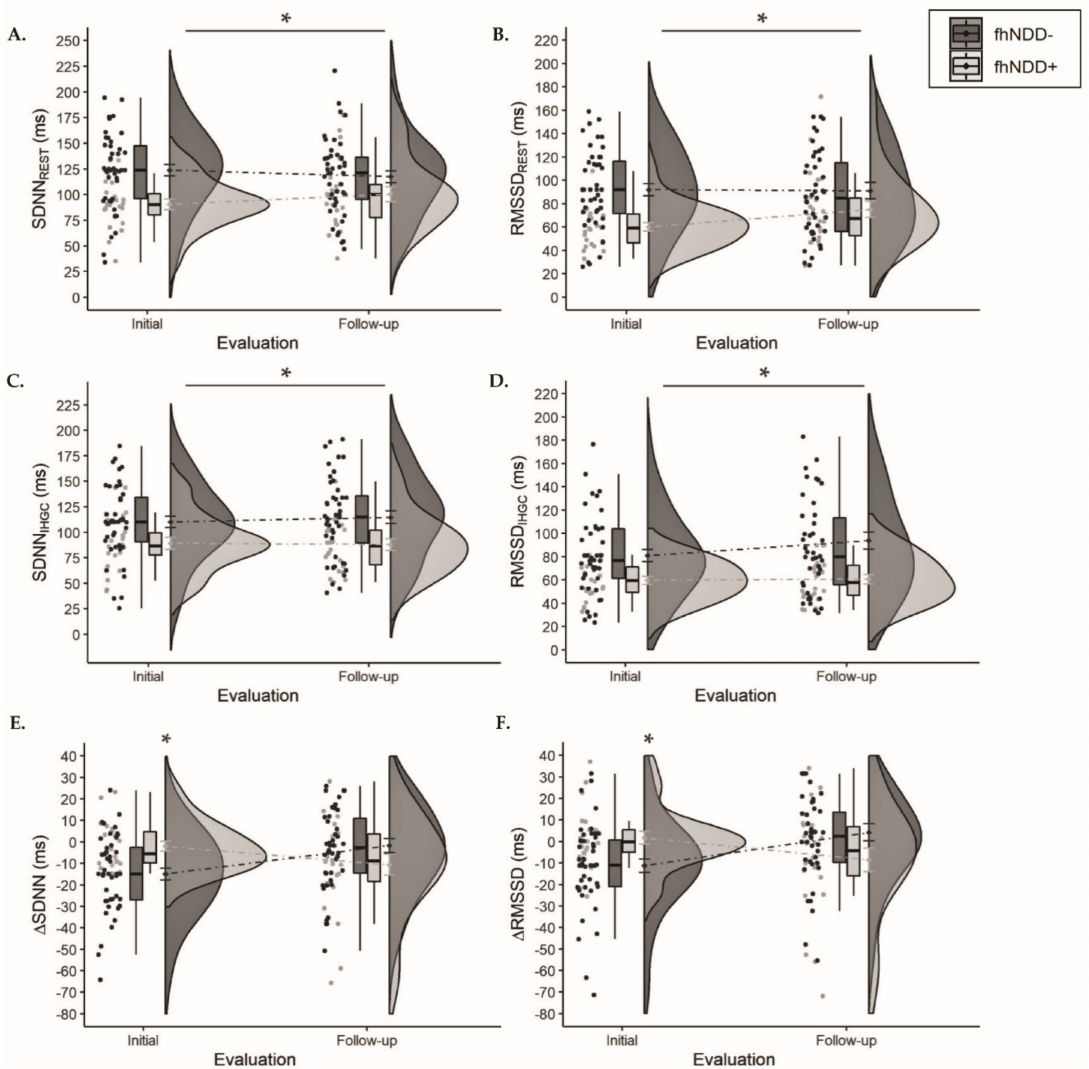
Figure 5. Group comparisons of HRV between those with a family history of neurodegenerative disease (fhNDD+; light gray) and without a family history of neurodegenerative disease (fhNDD − ; dark gray) during resonant breathing assessments at each evaluation. ( A ) SDNN at rest. ( B ) RMSSD at rest. ( C ) SDNN during isometric handgrip contraction (IHGC). ( D ) RMSSD during isometric handgrip contraction (IHGC). (E) Change in SDNN from rest to IHGC. ( F ) Change in RMSSD from rest to IHGC.* p <